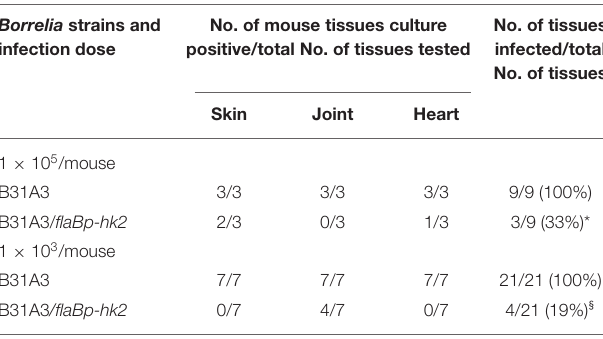
TABLE 2 | The infectivity of the hk2 overexpression